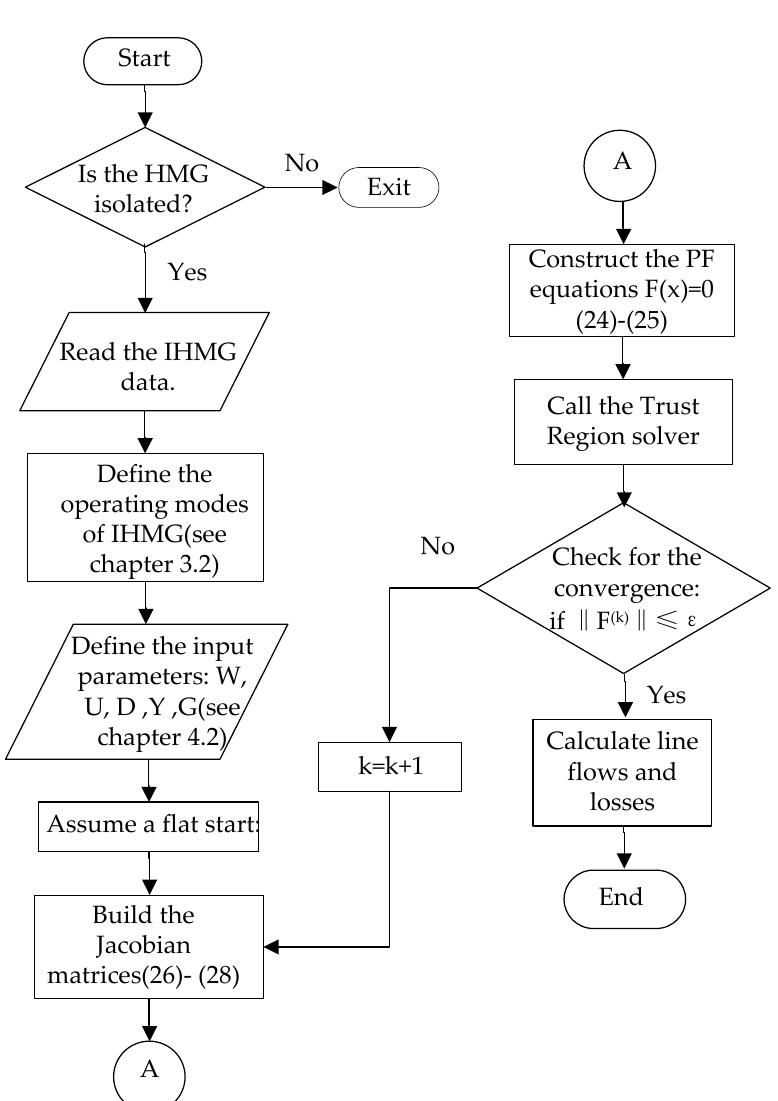
Figure 3. Flow chart of the proposed mode-adaptive power flow algorithm of IHMG.